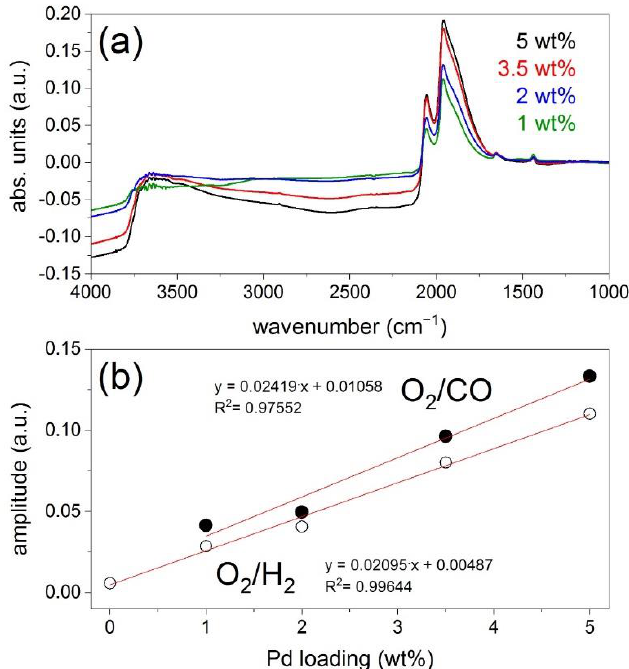
Figure 5. ( a ) Selected phase-resolved spectra (all at φ PSD = 170°) of O 2 /CO modulation experiments at 300 °C on the series of Pd/Al 2 O 3 catalysts. ( b ) Correlation between Pd loading and amplitude of modulations in correspondence of the signal at 2500 cm −1 taken as indicator for the baseline changes. (●) O 2 /CO and ( ○ ) O 2 /H 2 modulation experiments.